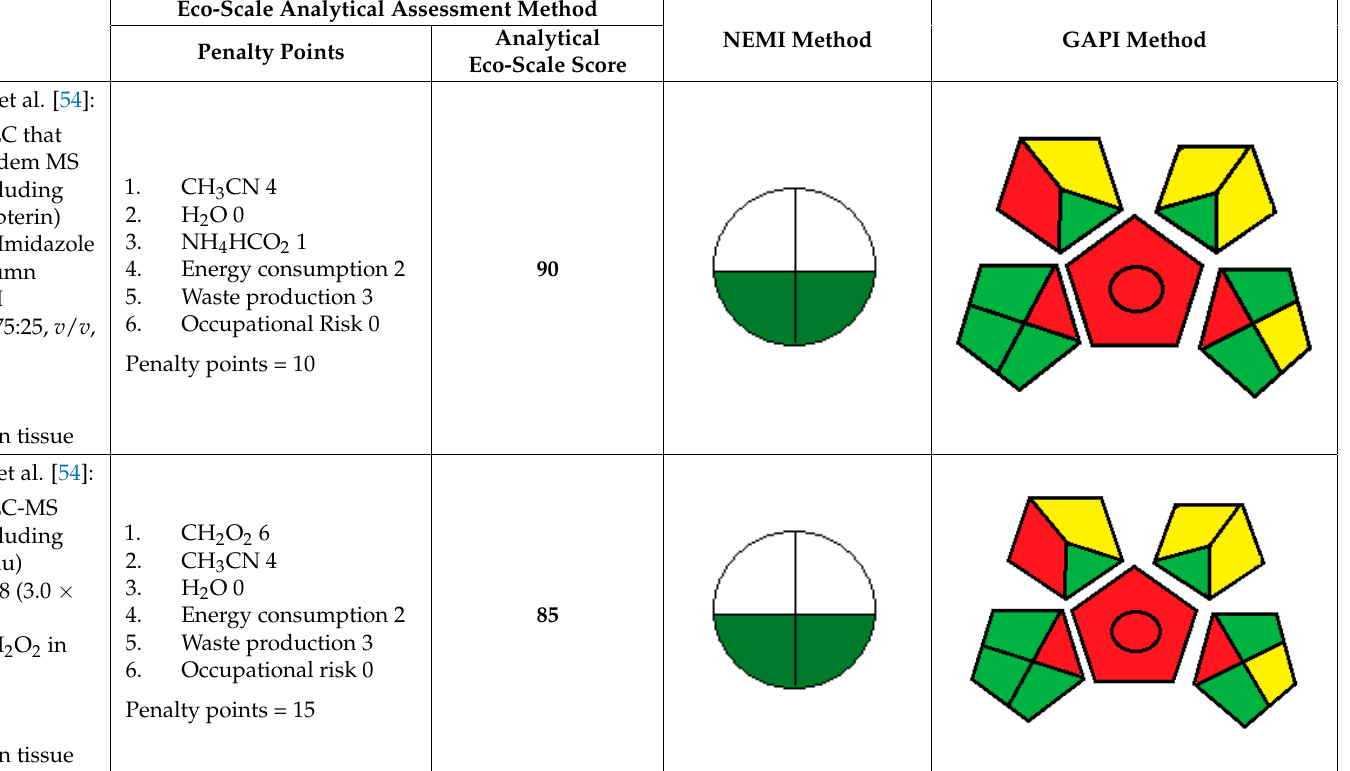
Table 1. ESA, NEMI, and GAPI tools for assessment of greenness values of different analytical methods described in the literature for determination of the studied neurotransmitters. Method Employed Instrument and Chromatographic Settings No.